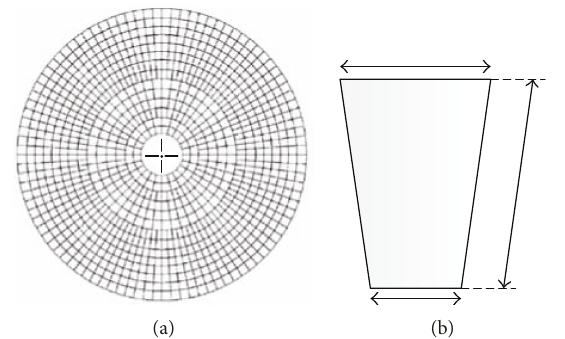
Figure 9: Segment design and panel dimensions of the SRT main re fl ector [72]. (a) Main re fl ector of the SRT; (b) geometry of the SRT panels.